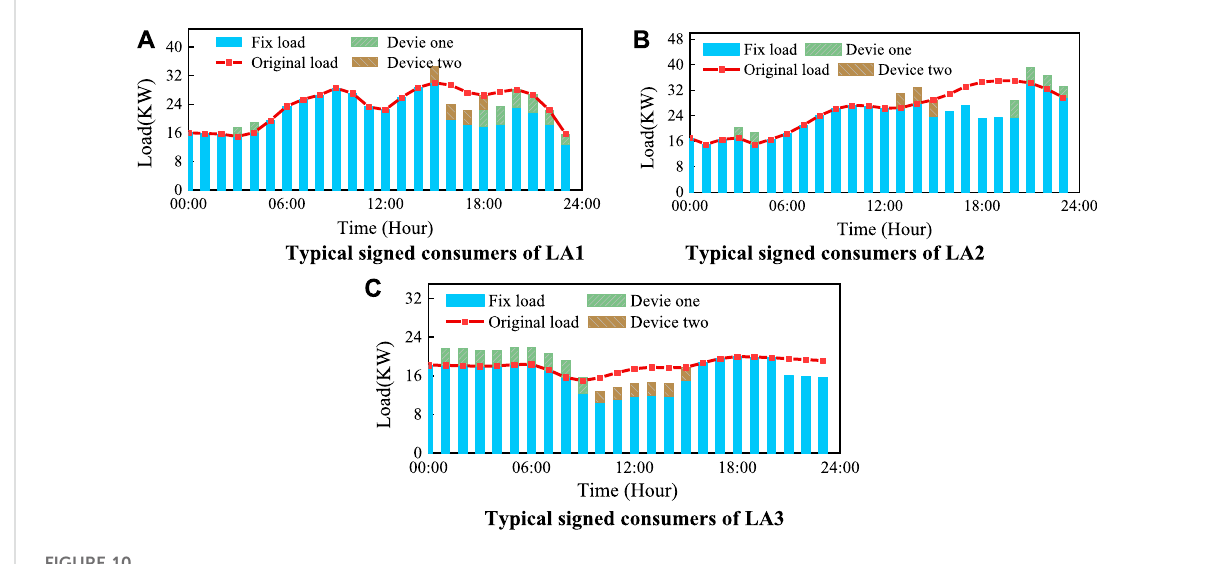
FIGURE 10 The control scheme for end-users ’ devices. (A) Typical signed consumers of LA1, (B) typical signed consumers of LA2, and (C) typical signed consumers of